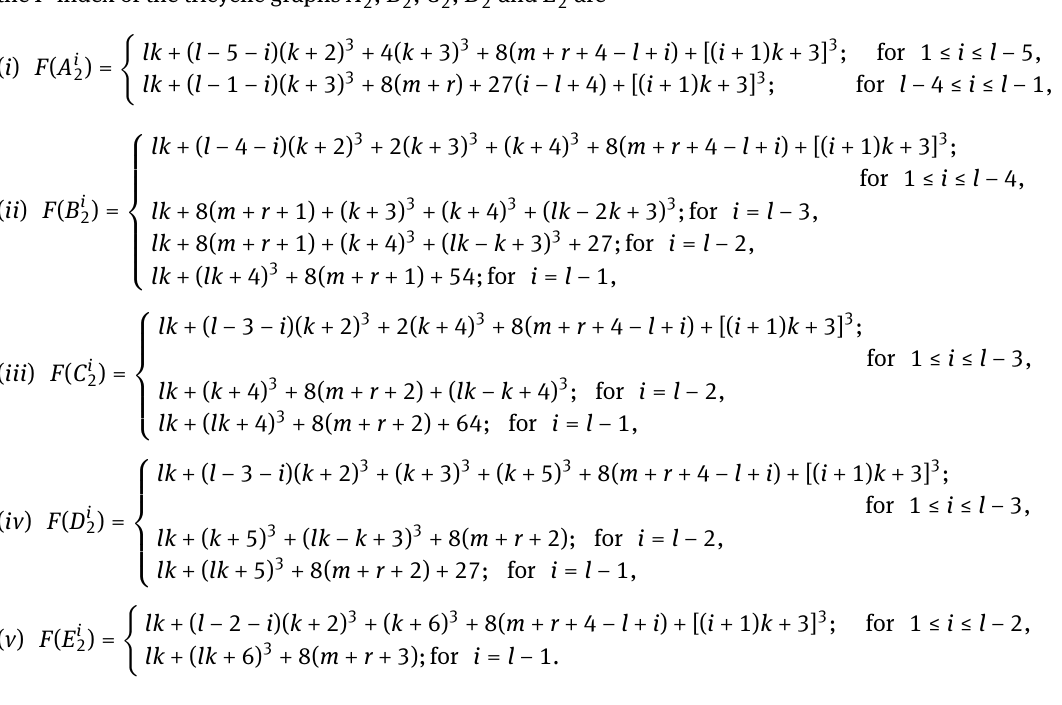
and (iv) E 4,0 (iii) E 7,0 (ii) B 3,2 4,2,1 3,2,2 4,2,1